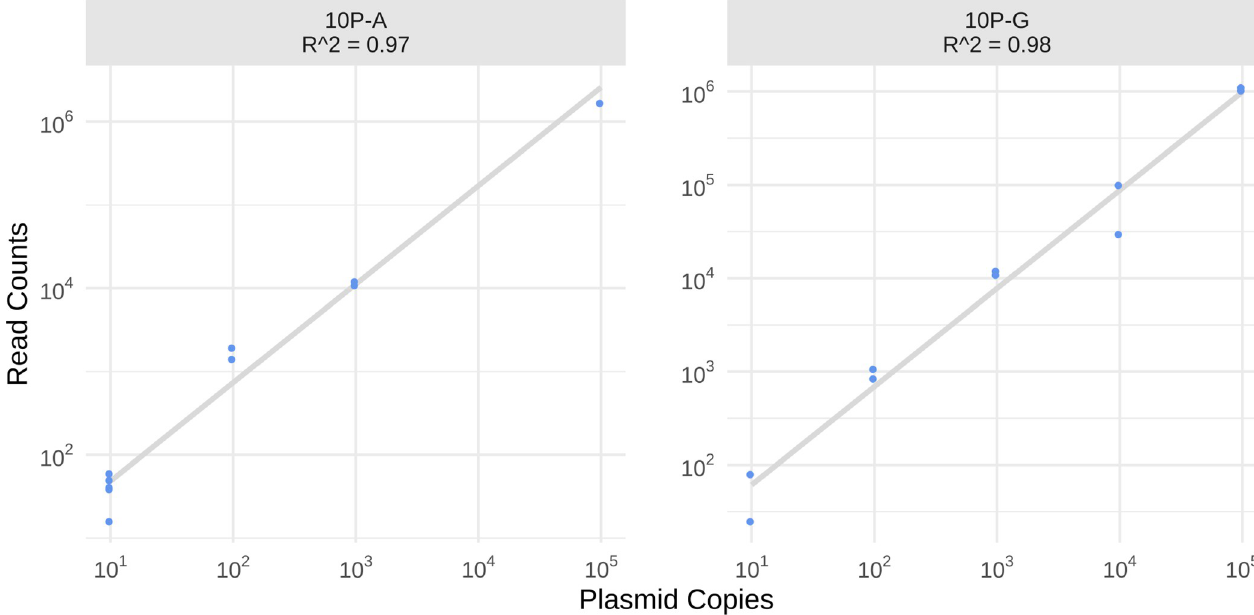
Fig 4. Linearity plots of 10-plasmid controls with L3 clustering parameter. The log10 transformed x-axis shows the copy number of plasmid inputs, the log10 transformed y-axis represents L3 clustered read counts. Linear regression trendlines are plotted in gray, with corresponding R 2 values. Linearity of the 10-plasmid control series 10P-A and 10P-G is shown (the linearity of additional 10-plasmid controls is shown in S6 Fig).